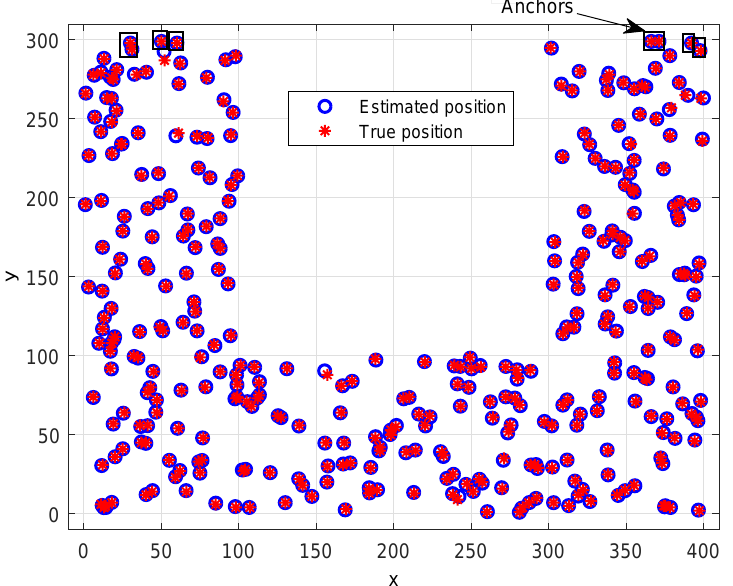
Figure 5. The true and estimated sensor positions at R = 40 and σ 2 = 0 dB, first configuration, CFM